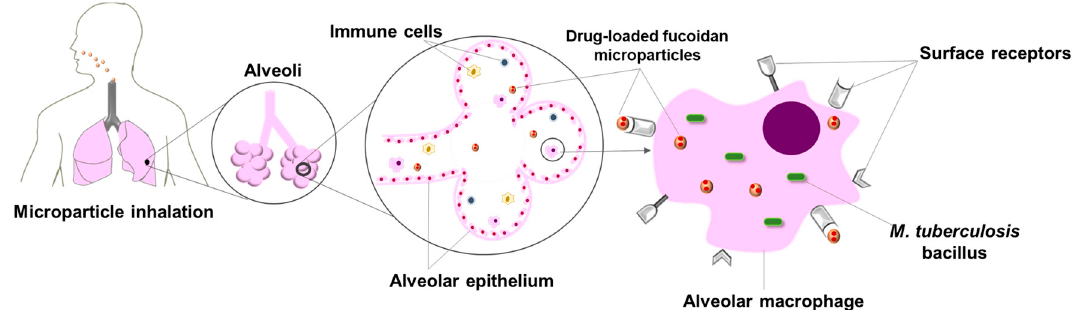
Figure 1. Illustration of microparticle uptake by alveolar macrophages, assuming targeted drug delivery mediated by fucoidan. Drug-loaded fucoidan microparticles reach the alveoli upon dry powder aerosolisation. Next, alveolar macrophages, infected with M. tuberculosis , engulf the microparticles. Fucoidan is expected to facilitate phagocytosis, because it possesses chemical moieties that are recognisable by the macrophage surface receptors.